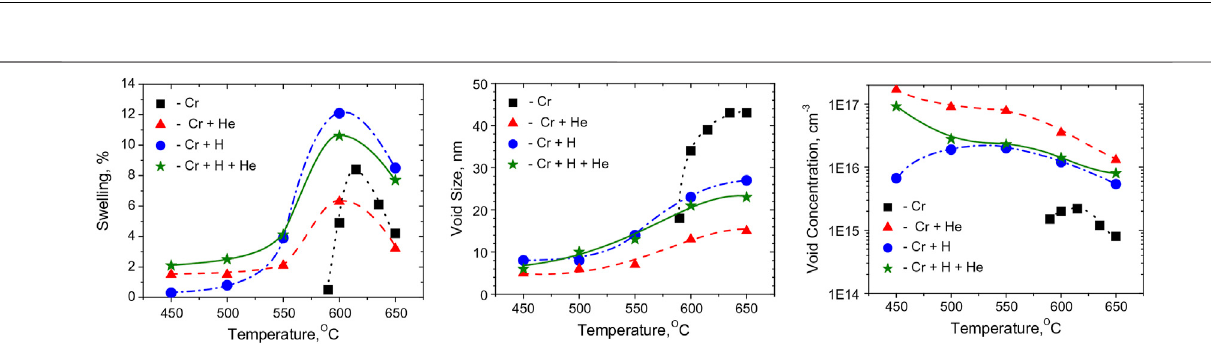
Frontiers in Materials |